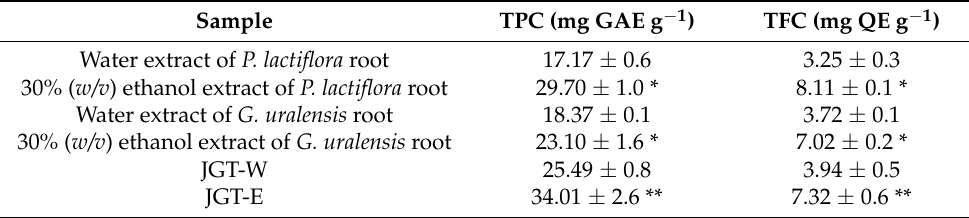
Table 1. Total phenolic content (TPC) and total flavonoid content (TFC) in Jakyakgamcho-tang (JGT) and its constituents. Sample TPC (mg GAE g − 1 ) TFC (mg QE g − 1 ) Water extract of P. lactiflora root 17.17 ± 0.6 30% ( w/v ) ethanol extract of P. lactiflora root